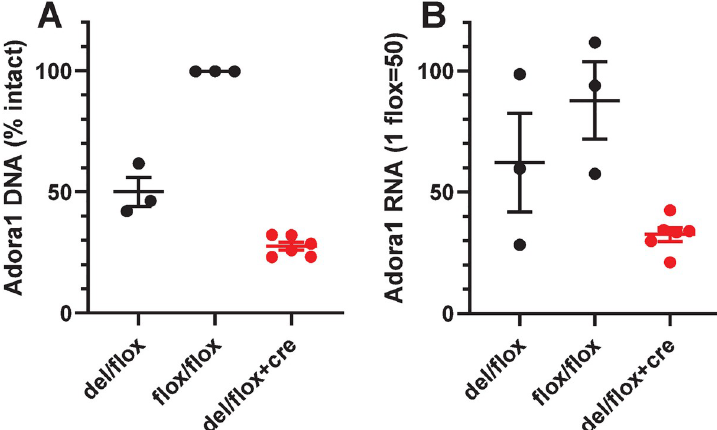
Fig 1. Levels of Adora1 DNA and RNA in mouse brain. (A) Adora1 DNA levels in brains from control (black, n = 3 del/flox and n = 3 flox/flox) and Syn1-Cre (red, n = 6 del/flox;Syn1-Cre) mice. The % intact is the % of the signal for two intact alleles, calculated assuming a level of 0% per deleted (del) allele and 50% per wild type or undeleted flox allele. The intact level of 27.6 ± 1.7% (different from 50% at P < 0.0001 by 1 sample t-test) in the del/flox;Syn1-Cre mice indicates 45% deletion of the flox alleles. (B) Adora1 RNA was measured in the same samples, assuming expression of 0% per del allele and 50% per wild type or undeleted flox allele. The RNA level of 32.6 ± 2.8% (different from 50% at P < 0.0001 by 1 sample t-test) in the del/flox;Syn1-Cre mice indicates 35% reduction per flox allele compared to wild type levels. DNA and RNA were extracted from one-half of the brain without cerebellum and brain stem and assayed as detailed in Methods. Data are mean ±